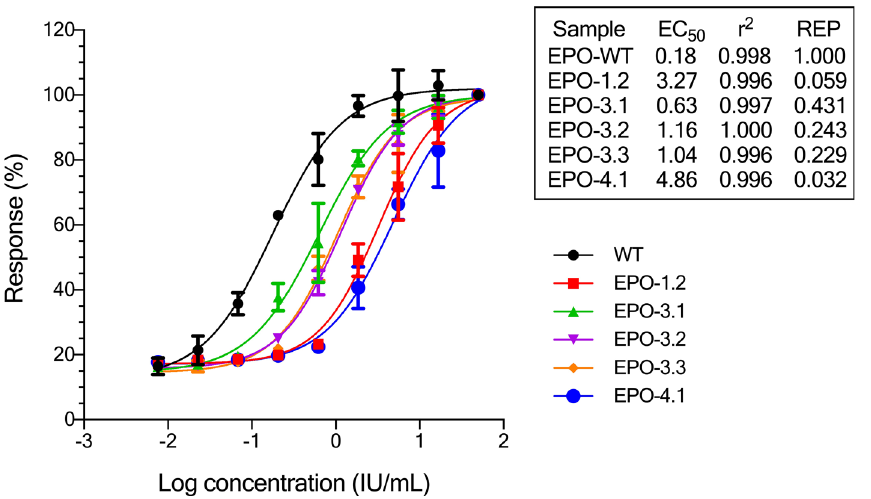
Figure 4. In vitro bioactivity of EPO-wild type and EPO mutants. EPO-WT ( ) and EPO mutants including EPO-1.2 ( ), EPO-3.1 ( ), EPO-3.2 ( ), EPO-3.3 ( ) and EPO-4.1 ( ) were tested for their bioactivity on TF-1 cells. Sample dilutions were done in quadruplicate. The absorbance reading corresponded to an increased cell number. The EC 50 , REP (relative activity compared to EPO-WT) and R 2 of a 4-parameter logistic regression model were calculated using Gen5 data analysis software. The log dose–response curve of a 4-parameter logistic regression was generated by GraphPad Prism version 8.4.3 for Windows (https :// www.graph pad.com/). WT, EPO-WT; 1.2, EPO-1.2 (L70V, V74L, L102I); 3.1, EPO-3.1 (T106A); 3.2, EPO-3.2 (T106G); 3.3, EPO-3.3 (T106H); 4.1, EPO-4.1